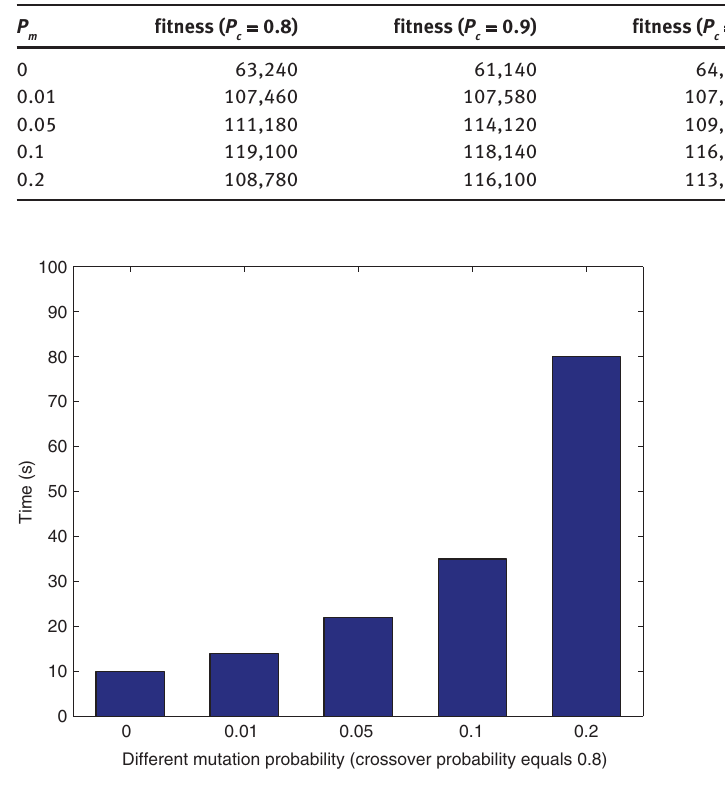
Figure 2. Running Time for Different Mutation Probabilities.